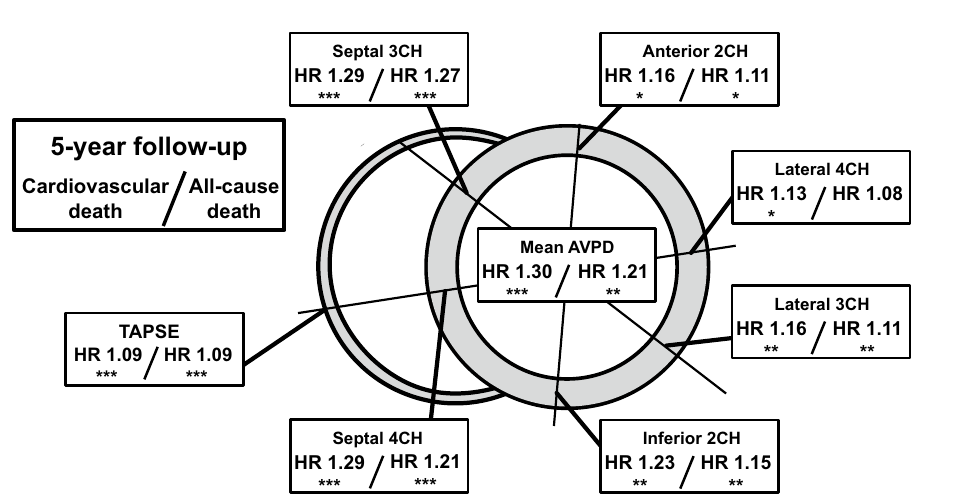
Figure 4. Prognostic values by measurement location. Univariate Cox regression analyses of the six different atrioventricular plane displacement (AVPD) locations. The short-axis slice illustrates hazard ratios (HR) for cardiovascular death and all-cause death at the 5-year follow-up for each location. Septal and average locations indicate higher HR values than lateral, anterior and inferior points. Asterisks represent *p < 0.05, **p < 0.01, ***p < 0.001. TAPSE tricuspid annular plane systolic